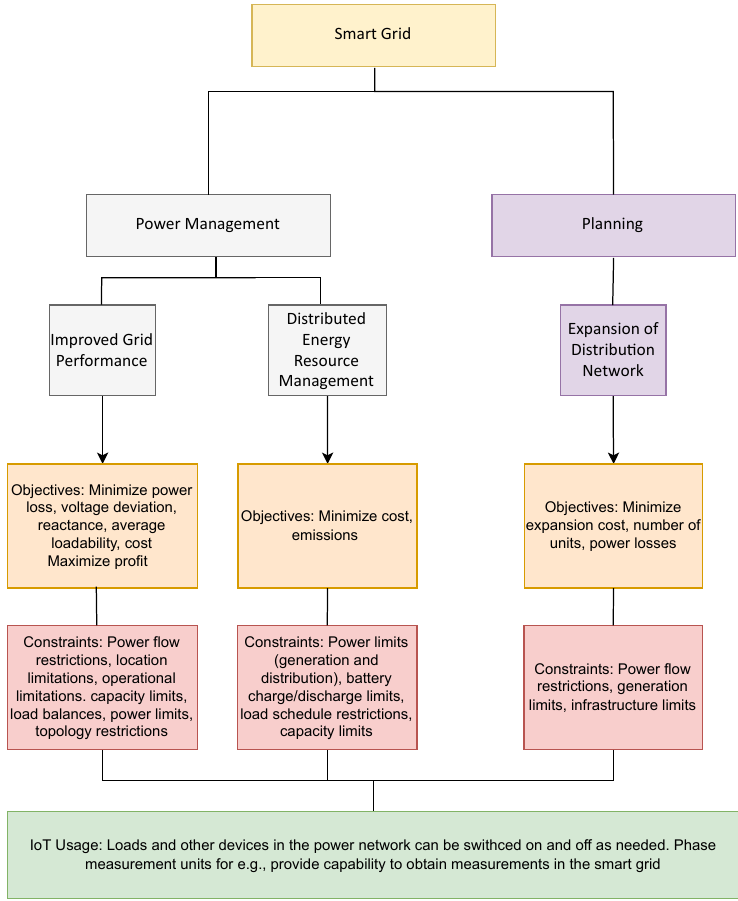
Figure 3. Optimization applications in Smart